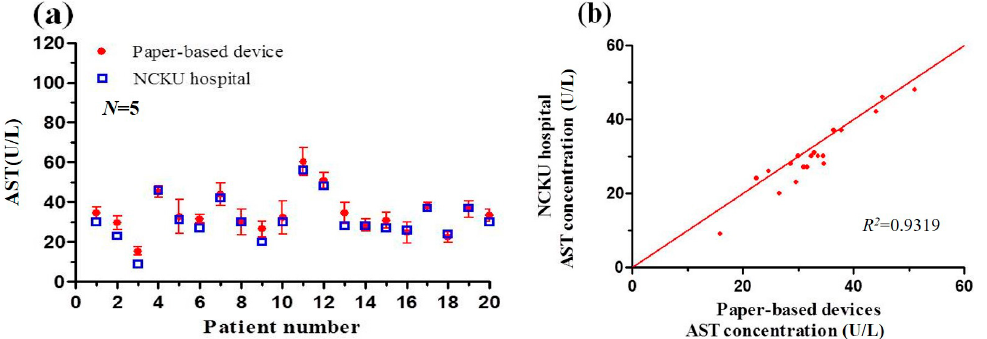
Figure 8. ( a ) AST concentration detection results obtained using paper-based analytical device and traditional spectrophotometric method from NCKU hospital; ( b ) Correlation between spectrophotometric results for AST concentration and paper-based analytical device results.